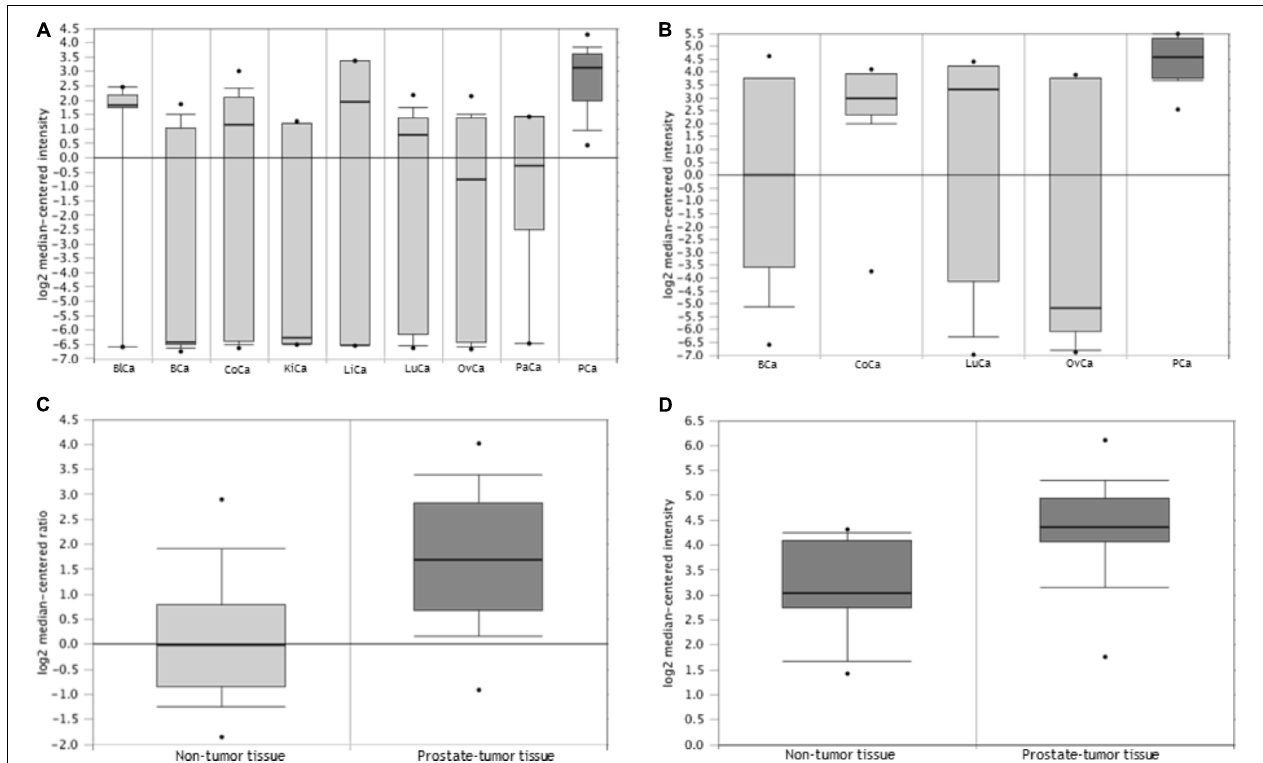
FIGURE 1 | TRIB1 is overexpressed in prostatate cancer. The Oncomine database showed that TRIB1 was overexpressed in (A) prostate cancer when compared to eight ( n = 174; Su et al., 2001), (B) and four other cancer types ( n = 76; Ramaswamy et al., 2003) and in prostate cancer when compared to adjacent cancer-free tissue with in (C) Grasso et al. (2012) dataset ( n = 122) and (D) Liu et al. (2006) dataset ( n = 57); BlCa, bladder cancer; BCa, breast cancer; CoCa, colorectal cancer; KiCa, kidney cancer; LiCa, liver cancer; LuCa, lung cancer; OvCa, ovarian cancer; PaCa, pancreatic cancer; PCa, prostate